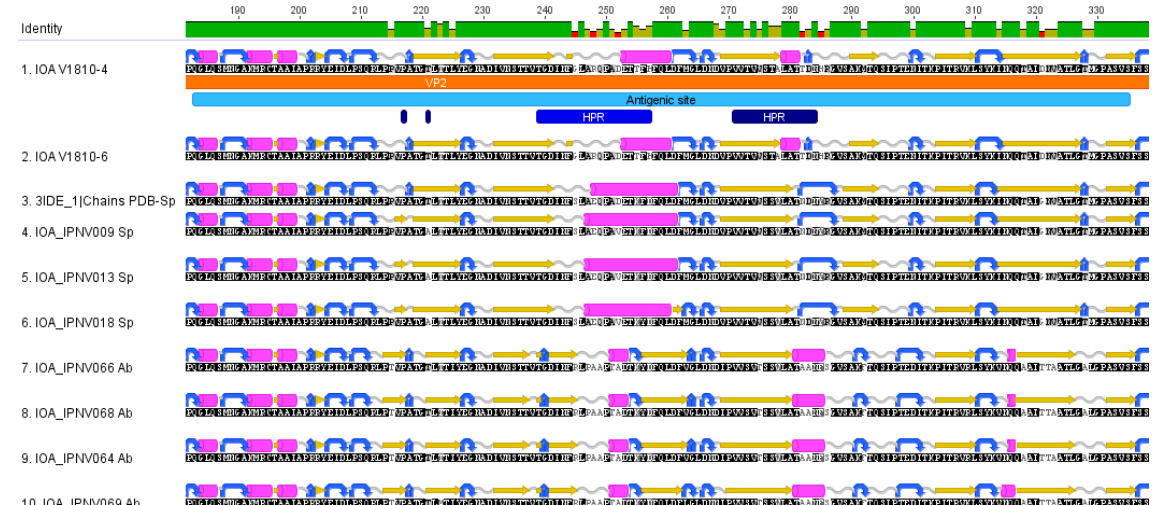
Figure 4. Secondary structures of VP2 proteins. The secondary structures of VP2 proteins among the Sp and Ab isolates and